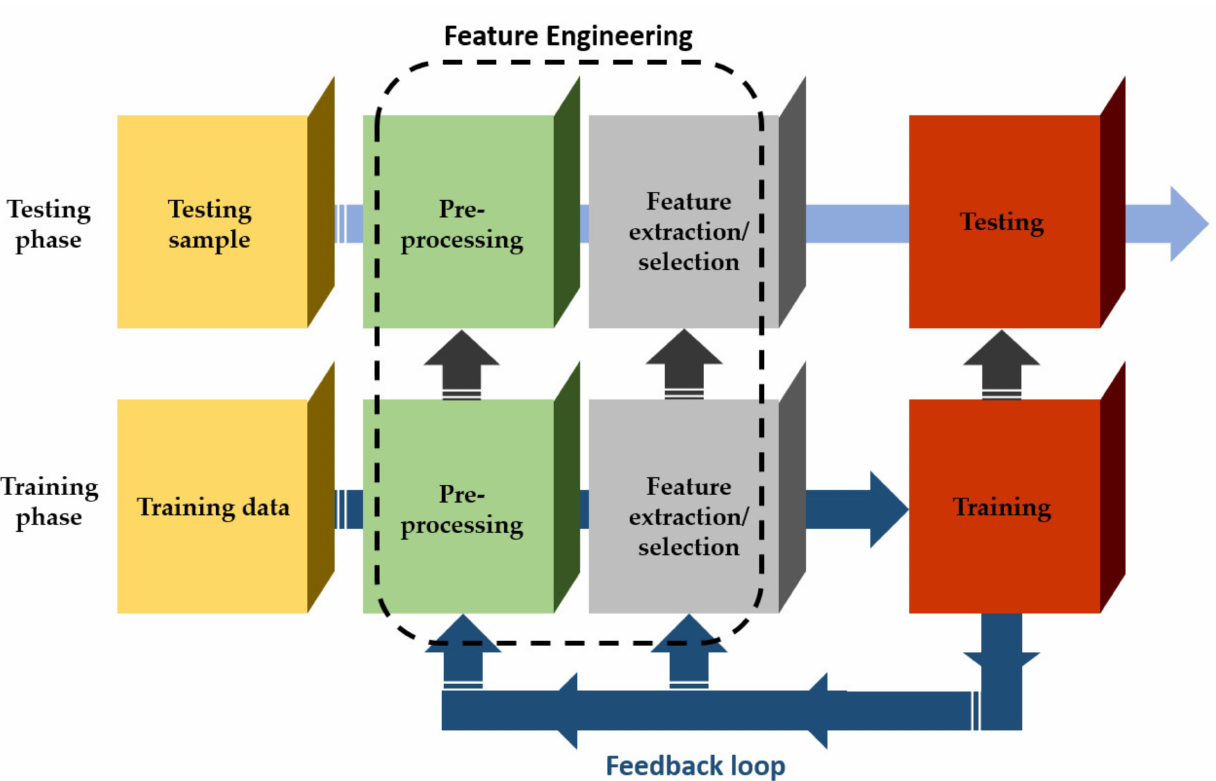
Figure 2. A graphical illustration of a typical machine learning